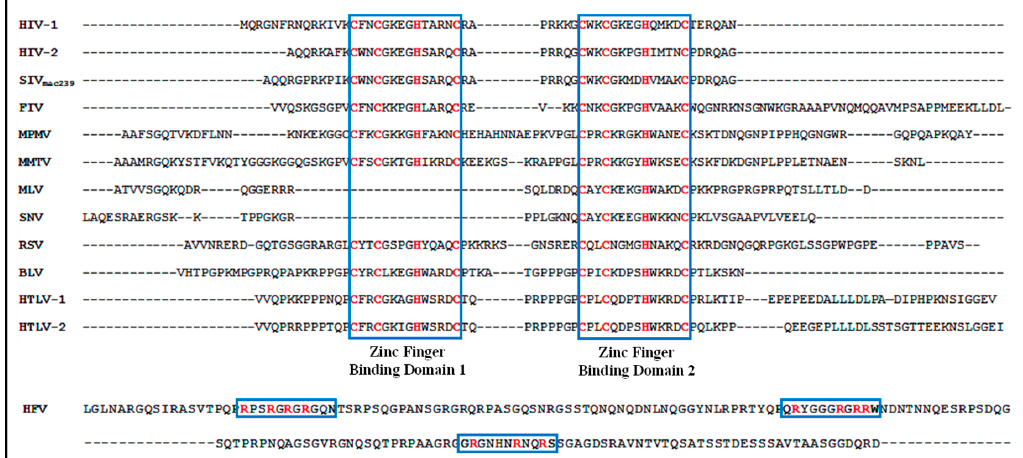
Figure 2. Multiple sequence alignment of the nucleocapsid region of the various Gag proteins of the listed retroviruses. The zinc finger binding domains present in the protein are boxed. The conserved cysteine (C) and histidine (H) amino acids of the zinc finger domains are shown in red. As can be observed, MLV and SNV contain only one zinc finger binding domain. The spumaviruses (e.g. HFV) are unique among retroviruses in that they contain three glycine ‐ arginine ‐ rich boxes instead of the cysteine ‐ histidine ‐ containing zinc finger domains [32]. Dashes have been added to facilitate the alignment of the differently sized nucleocapsid proteins.